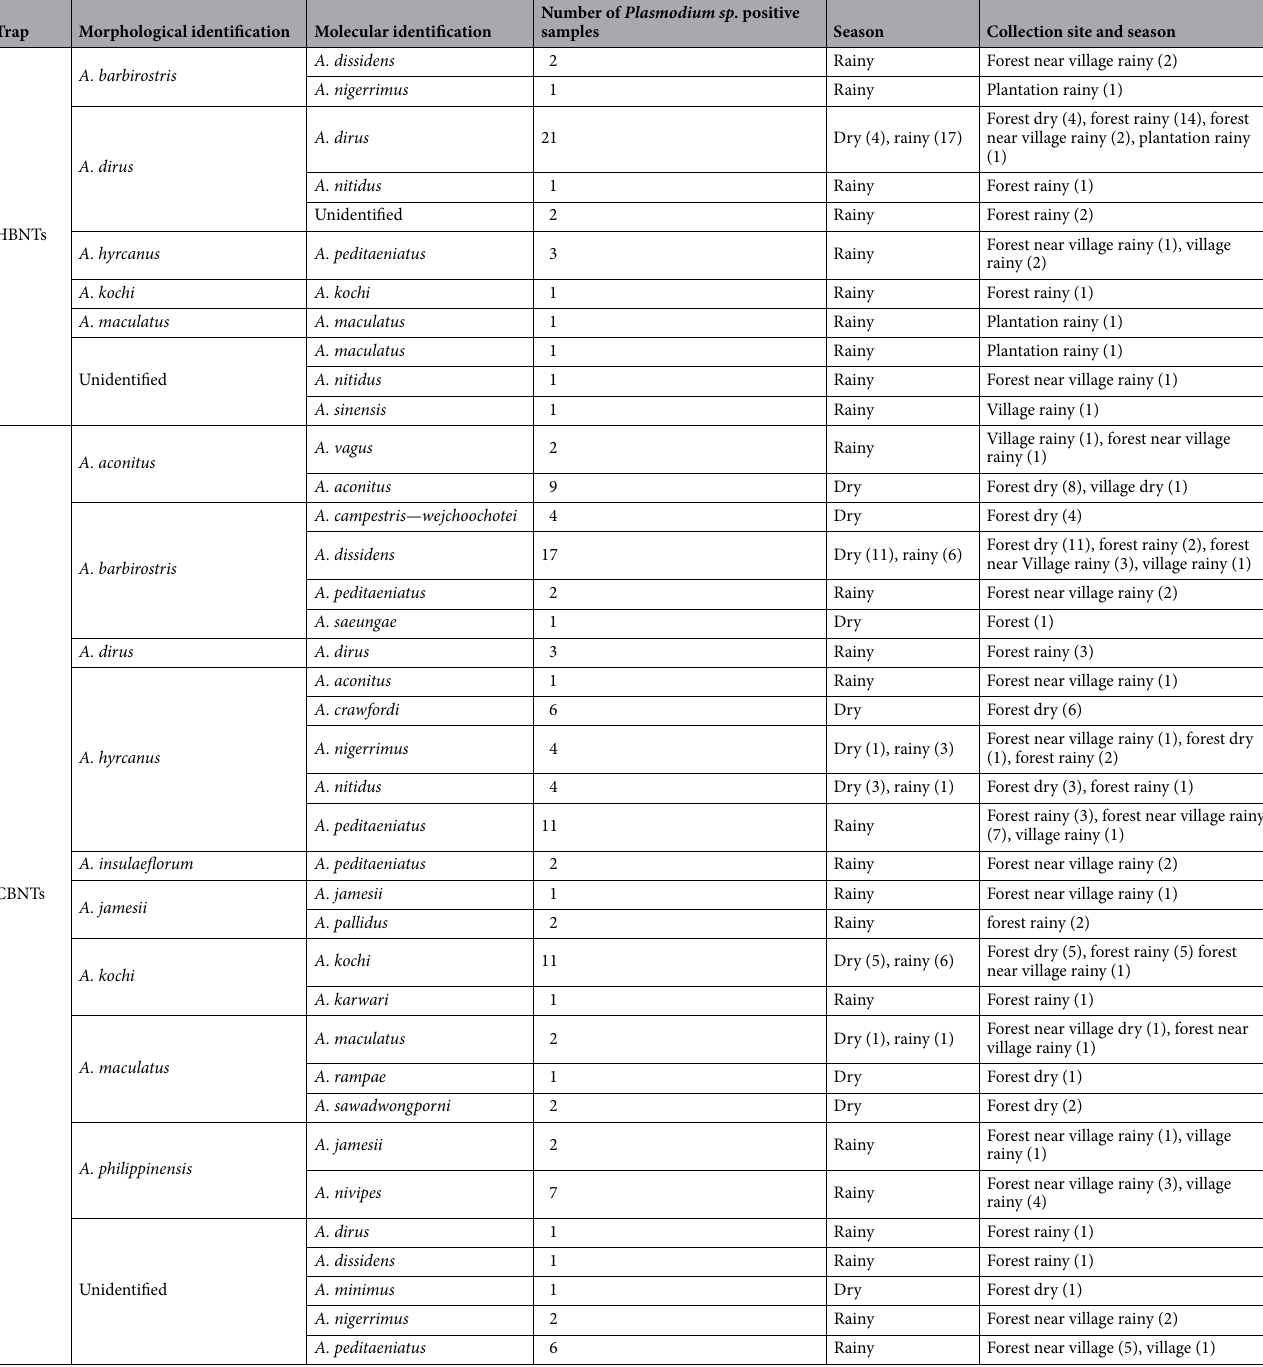
Table 2. Individual Plasmodium sp .-positive Anopheles specimens collected by HBNTs and CBNTs across sites and seasons. Sample sizes are given in